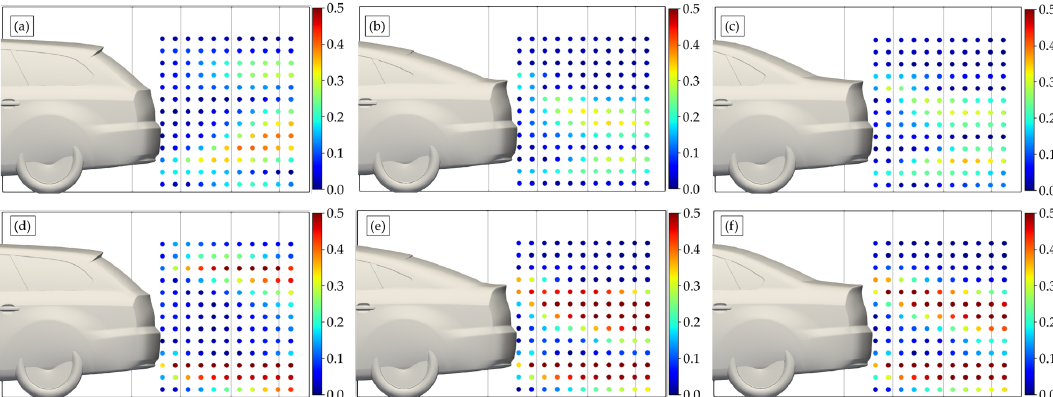
Figure 13. Figure illustrating plots of each sampled positions colored in accordance with the difference in values between the experiment and two numerical models. Figure ( a – c ) illustrate the estateback, fastback, and notchback models obtained from the results of the CFD model. In addition, Figure ( d – f ) depict the estateback, fastback, and notchback models that were obtained from the proposed model. Table 5. Summary of the computational environments, root mean square error of the results, and computational times.